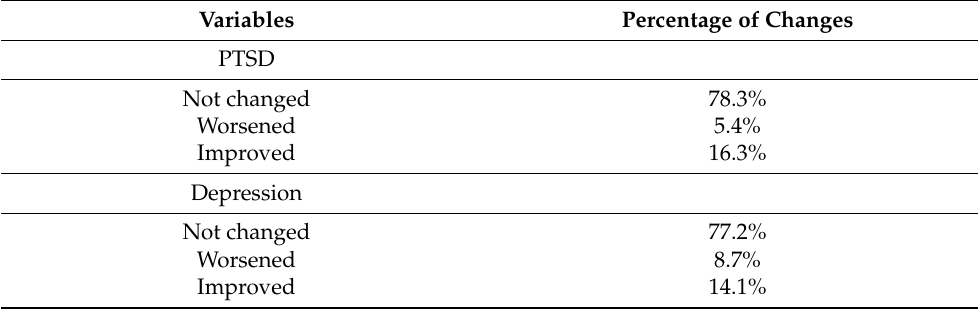
Table 2. Rate of changes in mental health symptoms over 18 months, N = 92.